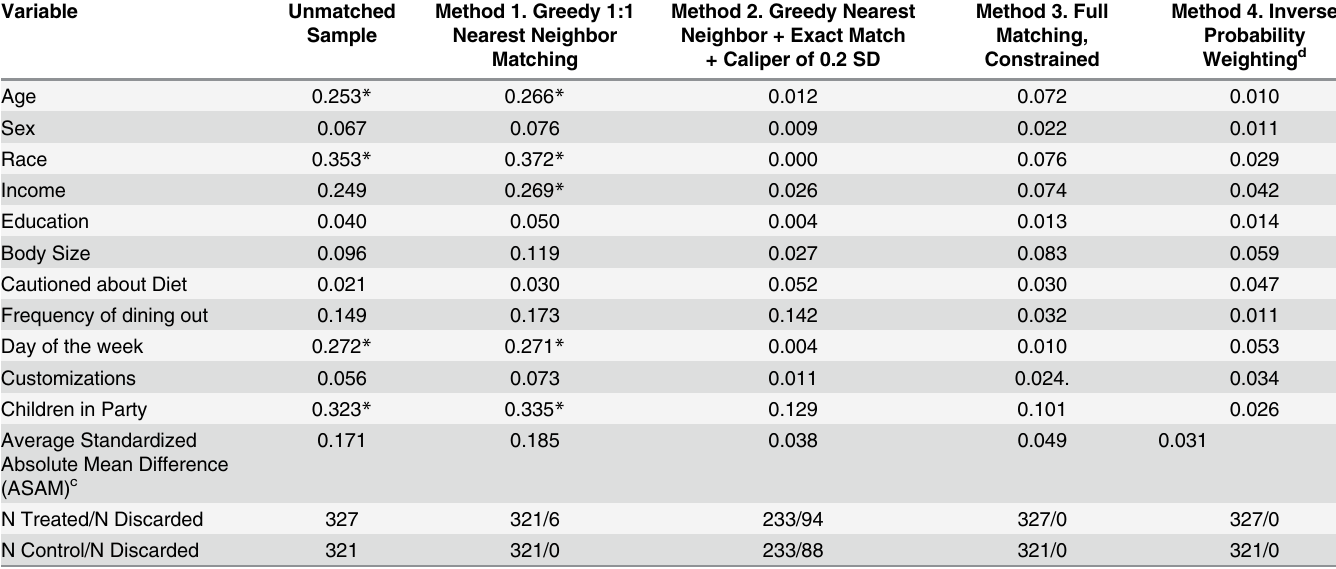
Table 2. Comparison of Absolute Standardized Biases a of Covariates between Treated (Labeled) and Control (Unlabeled) Subjects after Propen- sity Score Matching and Weighting b